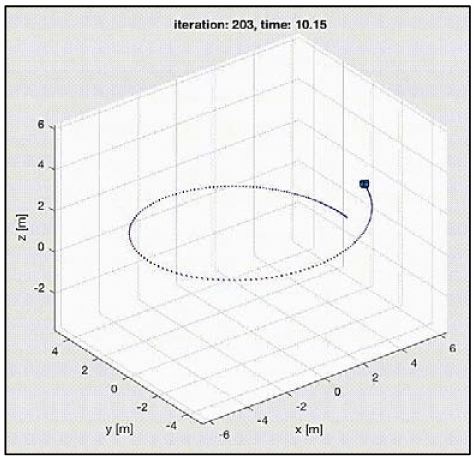
Figure 14. Performance of Proposed algorithm over circular trajectory.